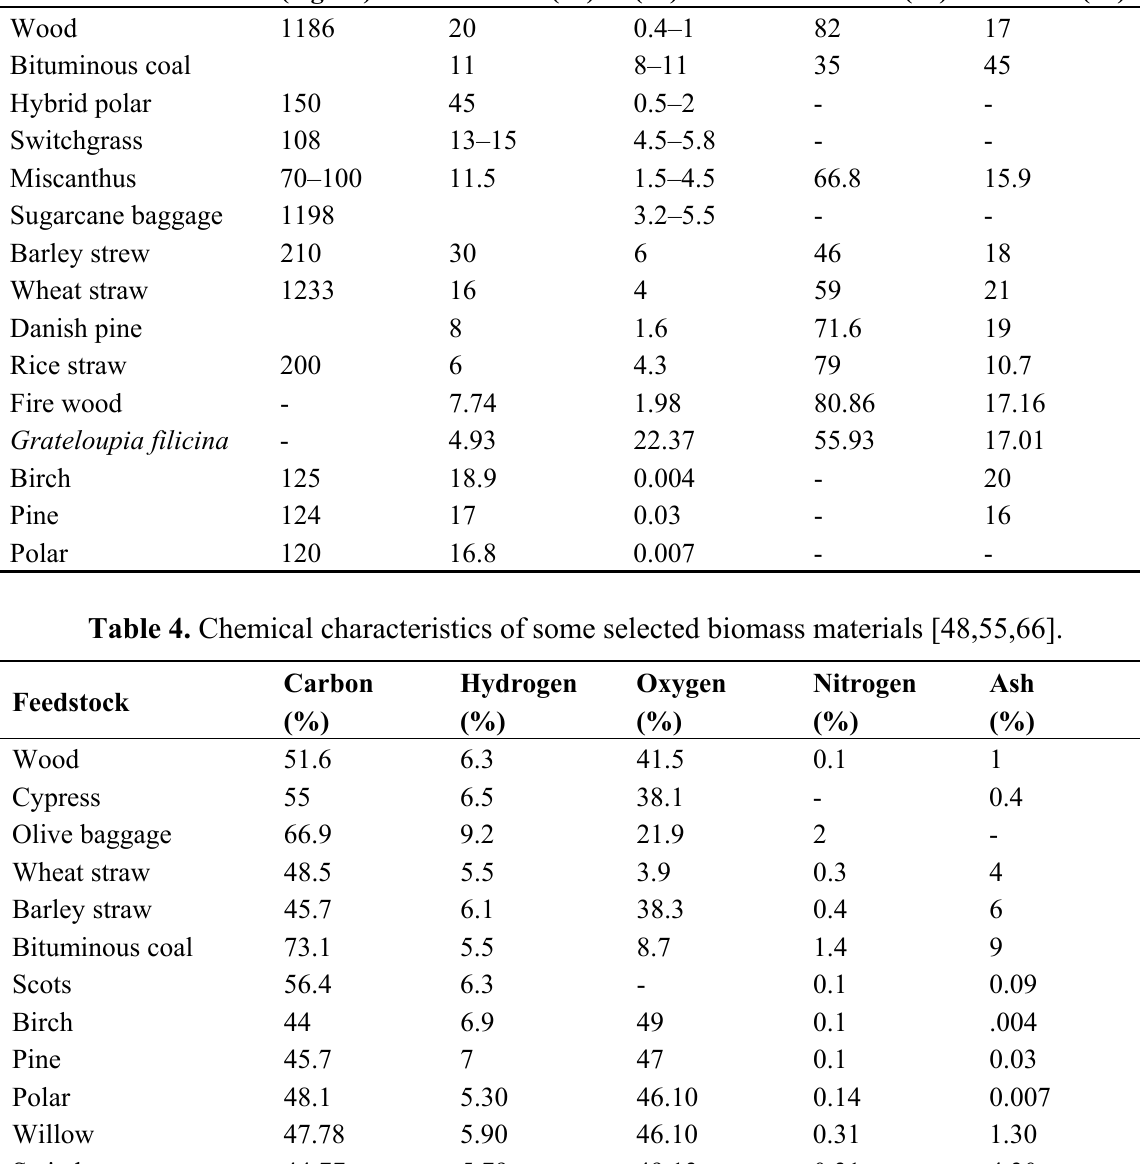
Table 3. Physical properties of selected biomass feedstock [45,48,54,55,65,66]. Feedstock